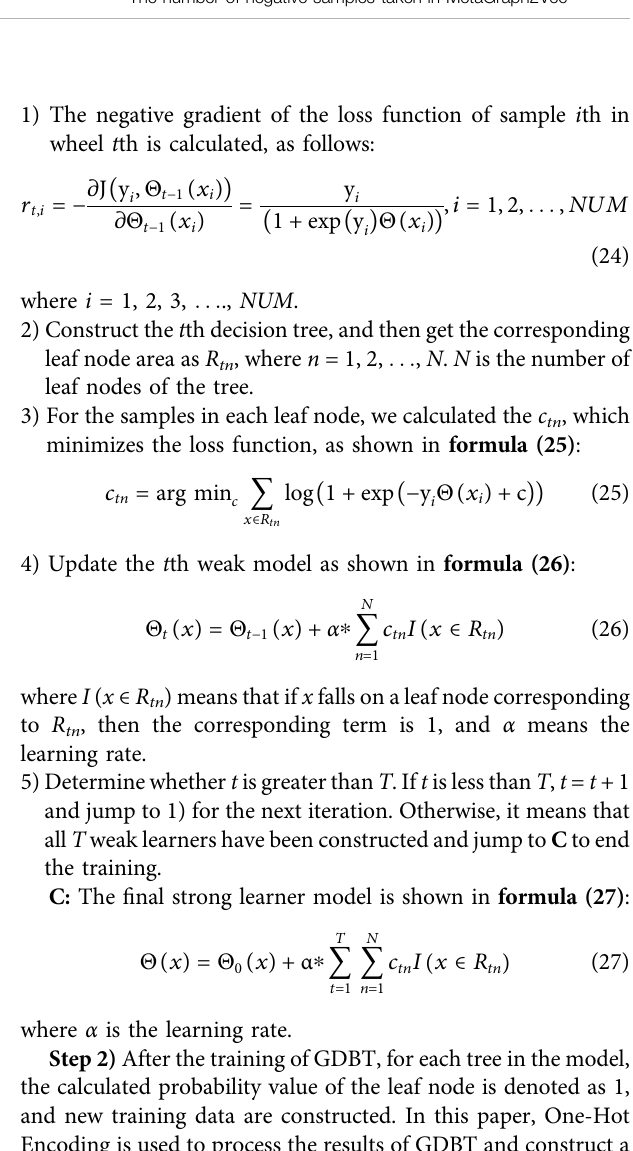
Note. lncRNA, long noncoding RNA.